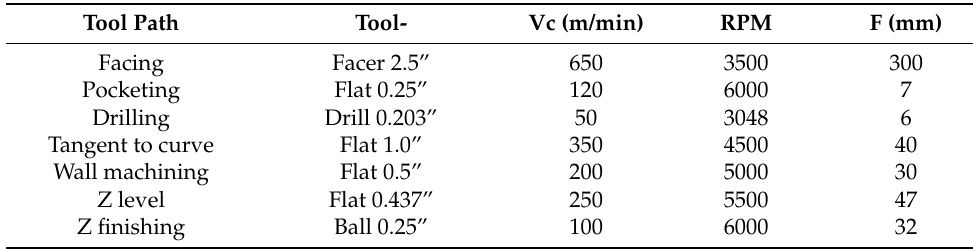
Table 1. Machining parameters for the workpiece manufacture. Milling parameters: Vc = cutting speed, RPM = spindle revolution per minute; F = feed rate.